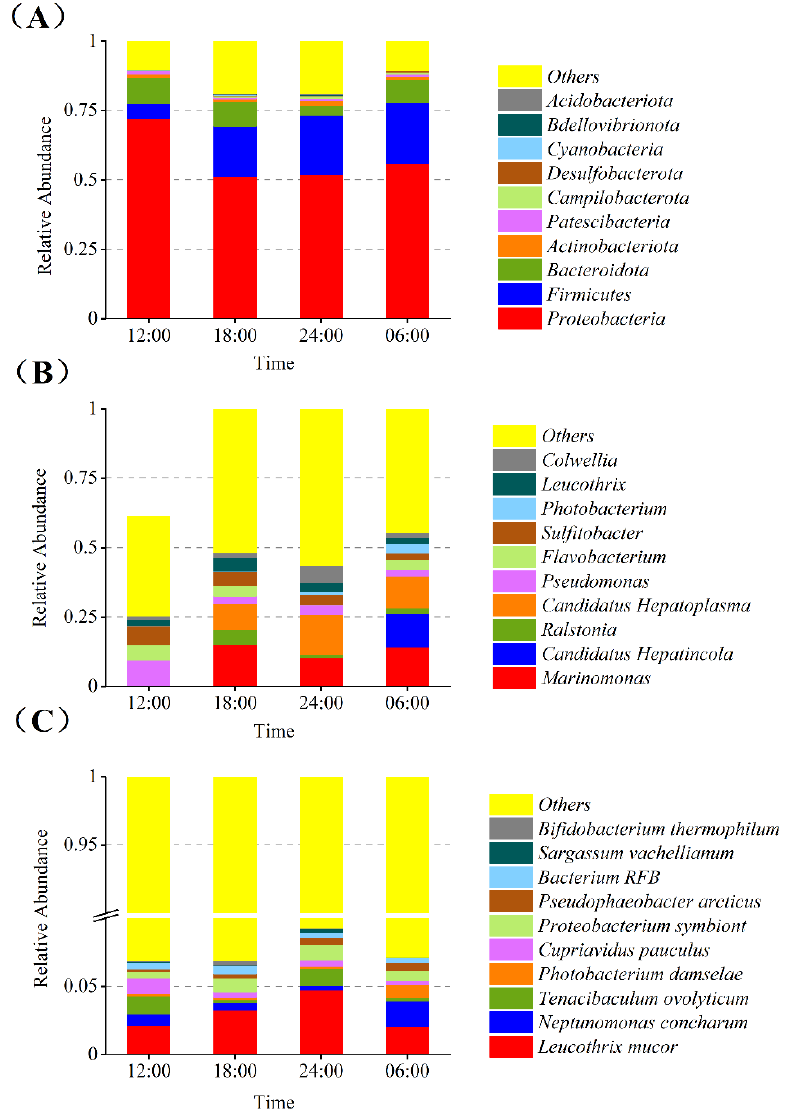
Figure 4. The relative abundance of the gut bacterial community. ( A ) Phylum levels. ( B ) Genus levels. ( C ) Species levels.